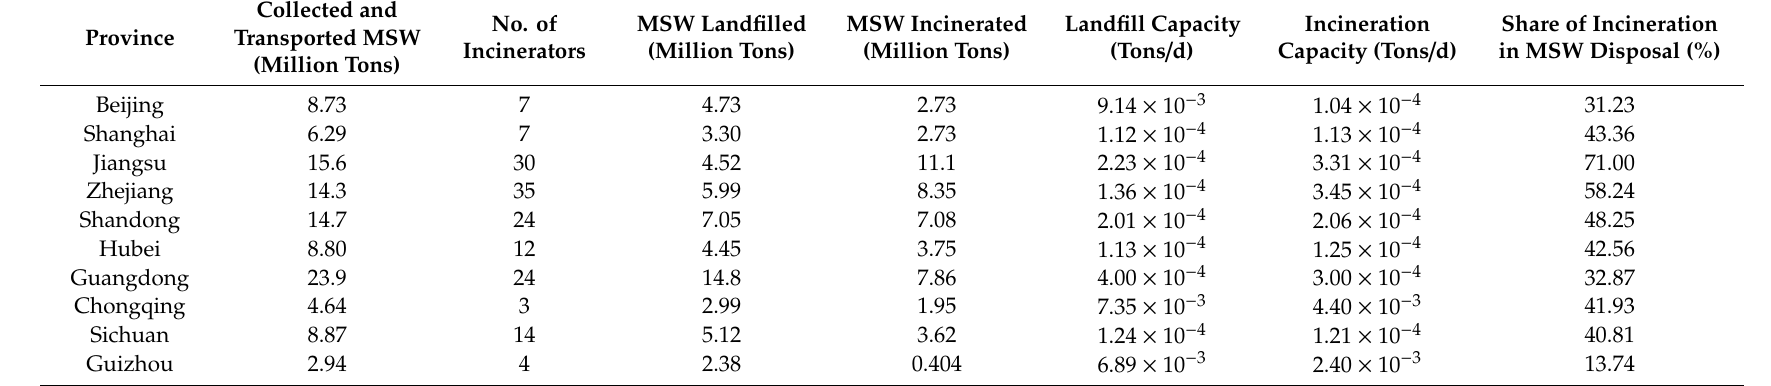
Table 3. MSW generation and disposal in selected provinces of China in 2016 (data from National Bureau of Statistics (NBS, 2017). Collected Province